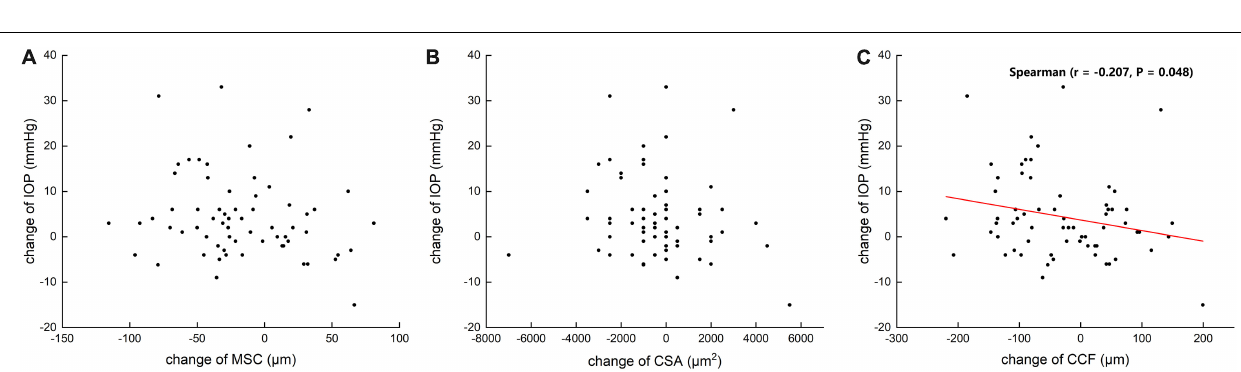
Frontiers in Physiology |